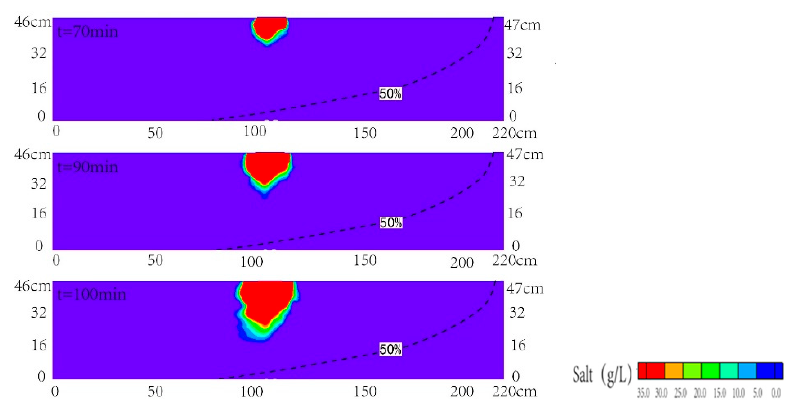
Figure 9. Simulated spatial saltwater contamination concentration distributions at different times when the injected saltwater concentration decreased to 15 g/L. The black dashed line denoted the contour line with the concentration of 0.5 time of seawater concentration.